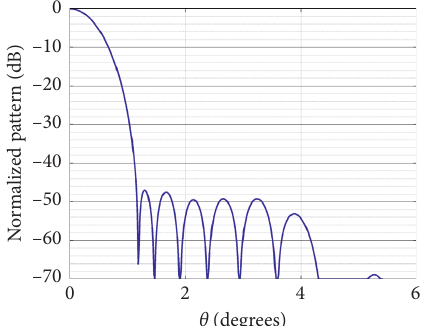
Figure 7: The two-way array pattern for N N r � 90 elements. SLL �− 47